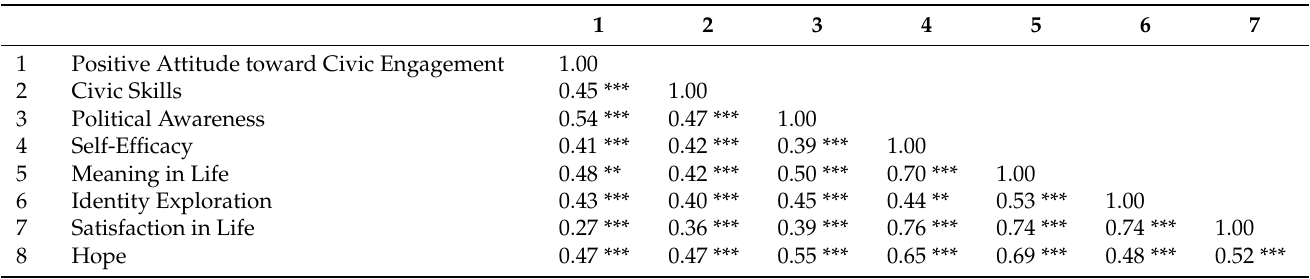
Table 1. Correlations between